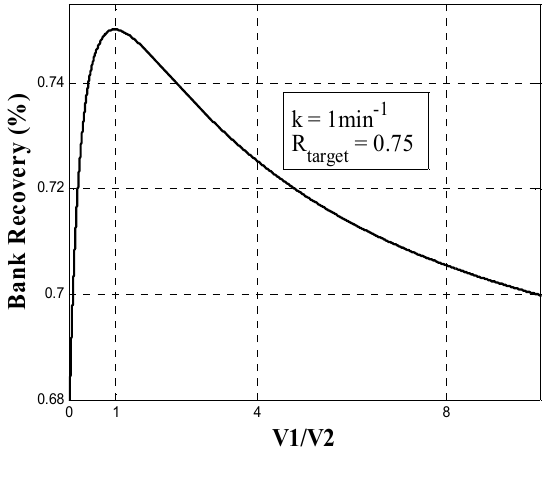
Figure 9. Two-cell bank recovery relative to bank recovery when cells are equal volume (V1/V2 = 1).